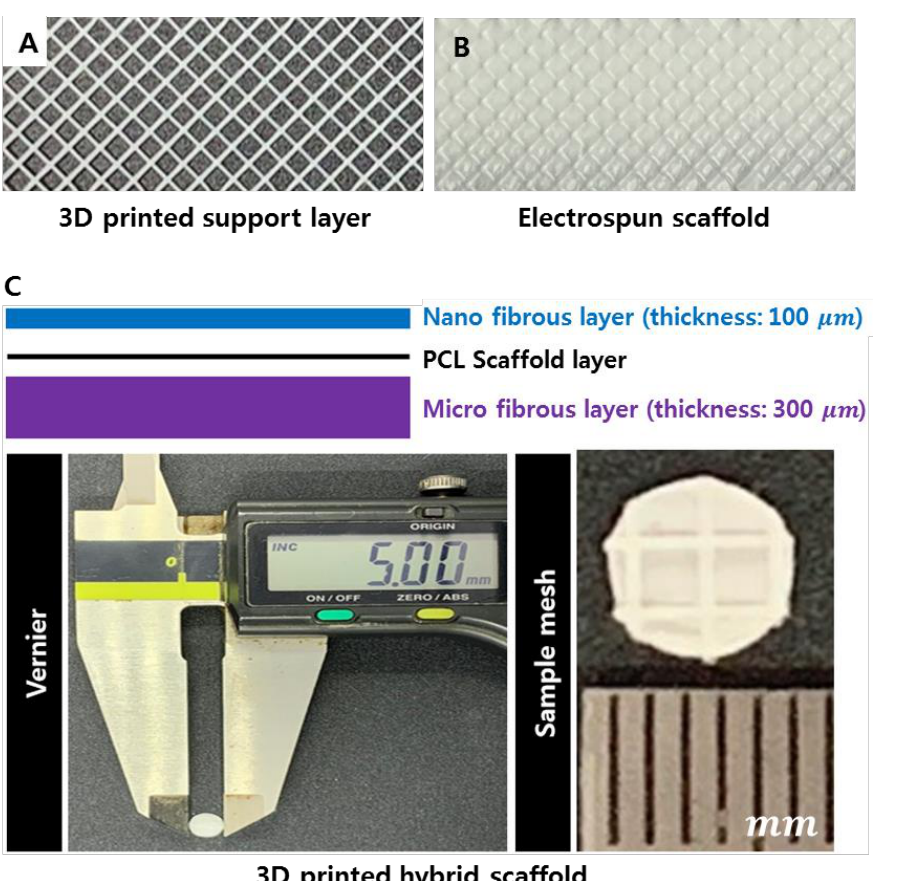
Figure 5. Fabrication results of the multi-layer scaffolds. ( A ) Optical image of the 3D-printed support layer, ( B ) optical image of the electrospun and 3D-printed scaffold, and ( C ) optical image of the three-layer electrospinning 3D-printed hybrid scaffold.